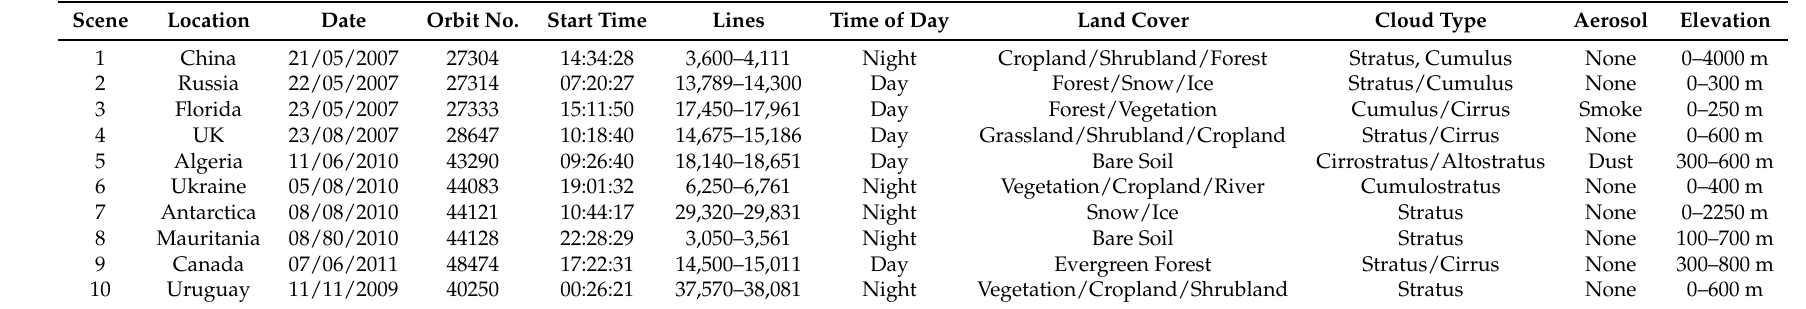
Table 1. Key characteristics of the ten submission scenes used within the cloud clearing